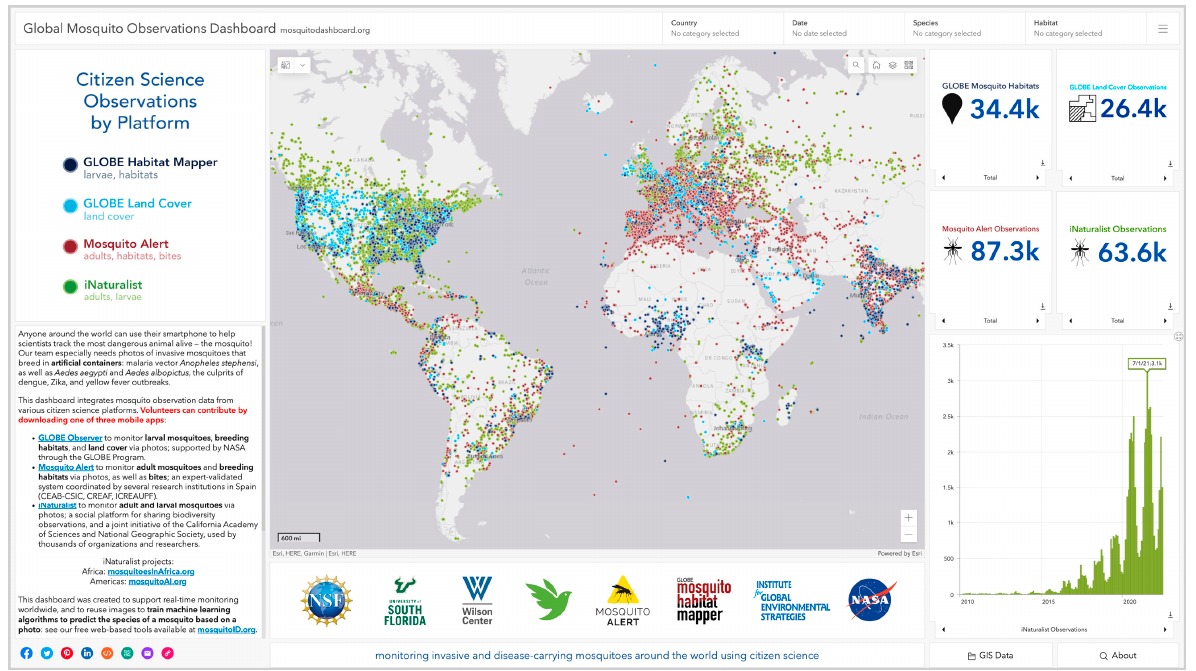
Figure 5. Screenshot of the Global Mosquito Observations Dashboard (mosquitodashboard.org, ac-